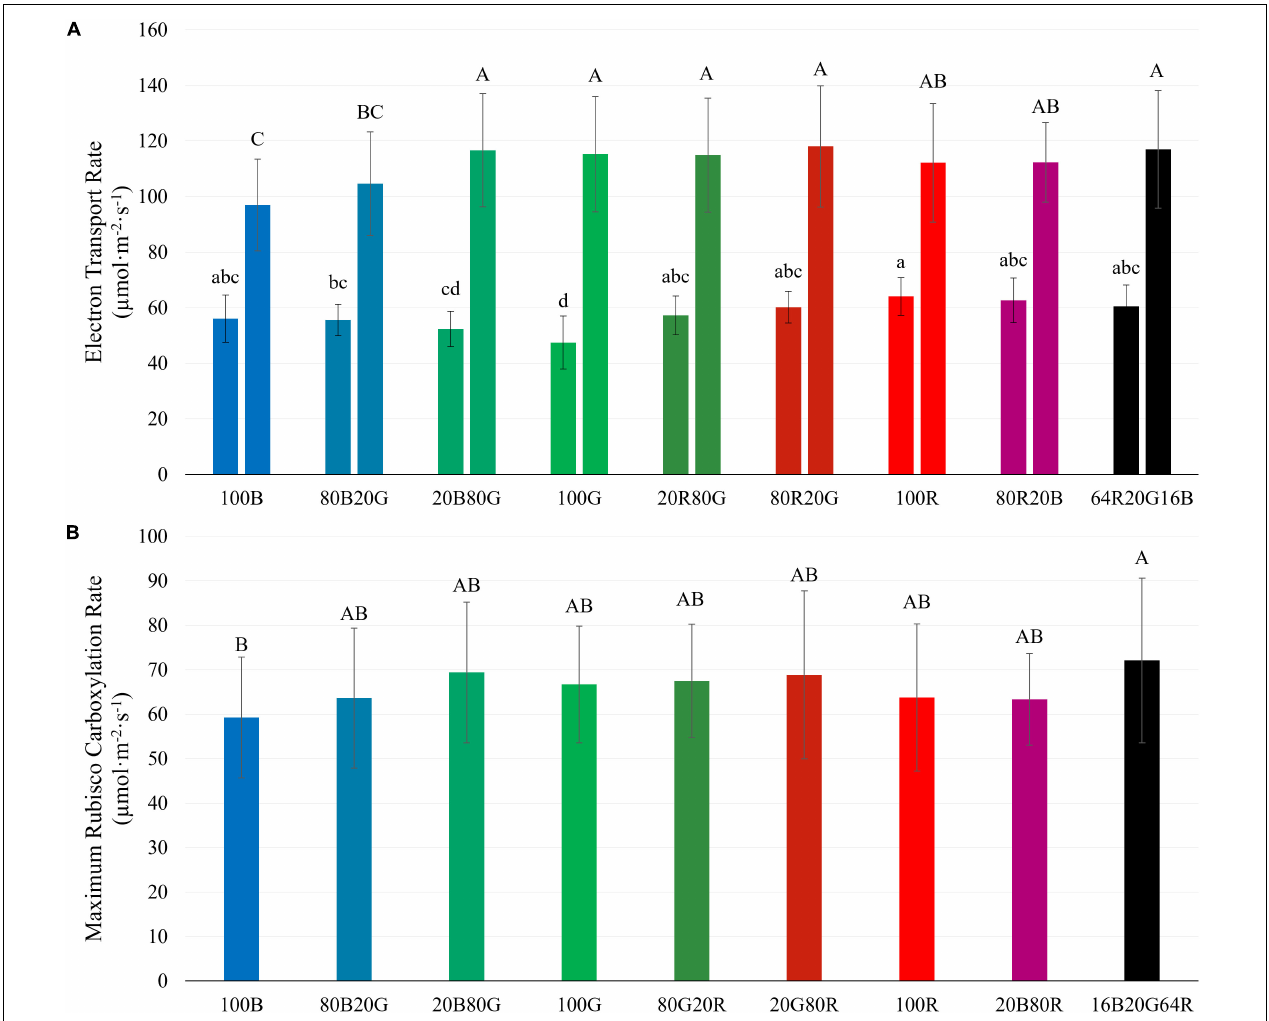
FIGURE 8 | Electron transport rate ( J ) at PPFD s of 200 (left bars) and 1,000 µ mol m − 2 s − 1 (right bars) (A) and maximum Rubisco carboxylation rate ( V c , max ) at a PPFD of 1,000 µ mol m − 2 s − 1 (B) of “Green Towers” lettuce, as estimated from A/C i curves under different light spectra. Bars with the same letter are not statistically different ( p ≤ 0.05). Error bars represent the standard deviation ( n = 9). The light composition of the nine light spectra is shown in Table 1